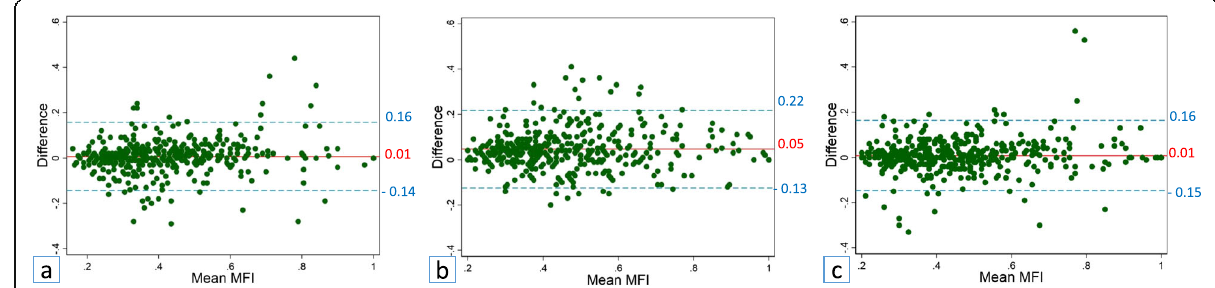
Fig. 4 Bland-Altman plots with mean differences in measurements of the muscle fat index (MFI, solid lines) and 95% limits of agreement (dashed lines) for repeated measurements by observer 1 ( a ), observer 2 ( b ), and observer 3 ( c )